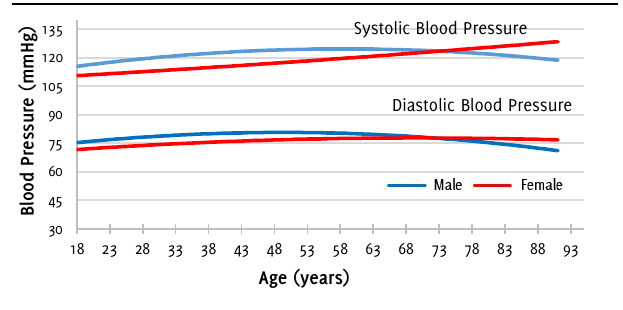
Figure 3 . Change in Blood Pressure with Age and Sex from Linear Polynomic Model.